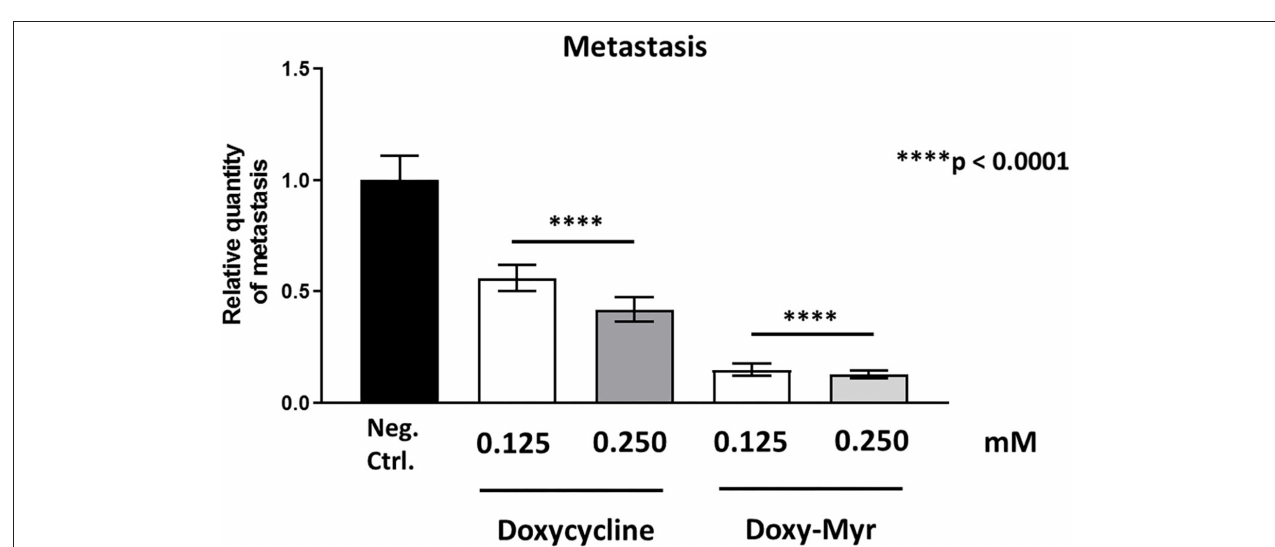
FIGURE 11 | Doxycycline and Doxy-Myr selectively target and prevent cancer metastasis. MDA-MB-231 cells and the well-established chorio-allantoic membrane (CAM) assay in chicken eggs were used to quantitatively measure spontaneous tumor metastasis. An inoculum of 1 × 10 6 MDA-MB-231 cells was added onto the Upper CAM of each egg (on day E9) and then eggs were then randomized into groups. On day E10, tumors were detectable and they were then treated daily for 8 days with vehicle alone (1% DMSO in PBS), Doxycycline or Doxy-Myr. After 8 days of drug administration, the Lower CAM was collected to evaluate the number of metastatic cells, as analyzed by qPCR with specific primers for Human Alu sequences. Note that Doxycycline and Doxy-Myr both showed significant effects on MDA-MB-231 metastasis. However, Doxy-Myr was clearly more effective than Doxycycline in inhibiting metastasis. Averages are shown ± SEM. **** p < 0.0001.